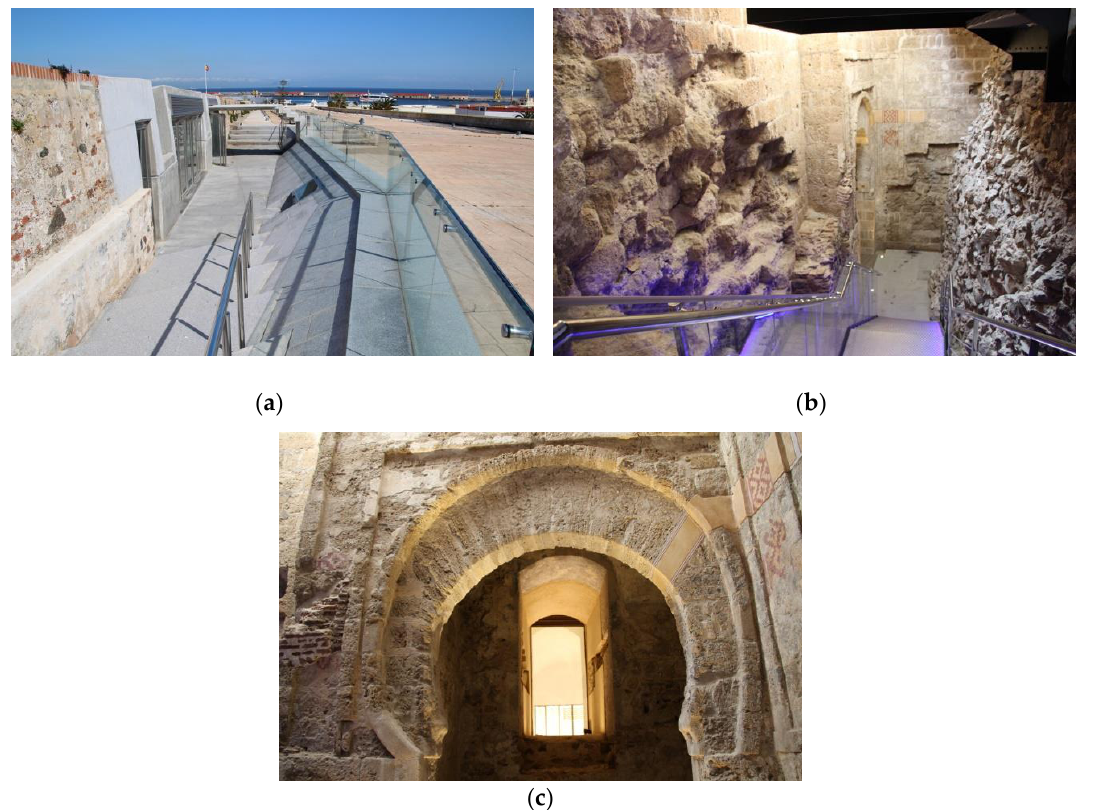
Figure 3. ( a ) Access to the archaeological site from the bailey. ( b ) Caliphal Gate and Wall after the works of enhancement. ( c ) Detail of the Caliphal Gate.